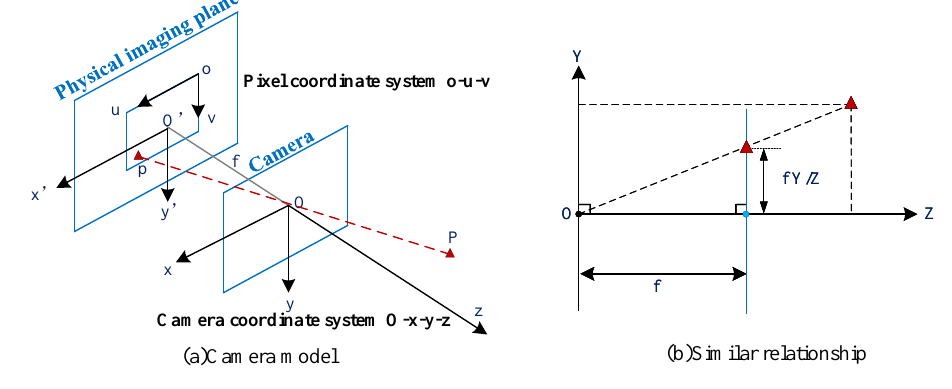
Figure 6. Camera model.